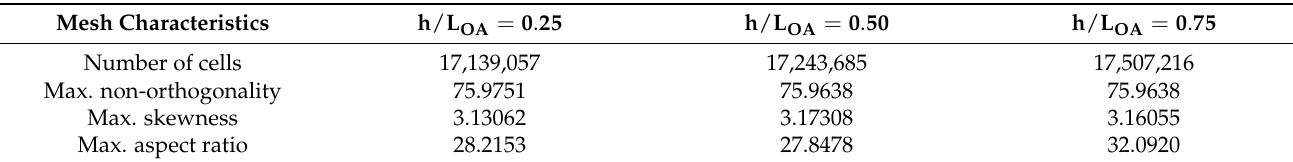
Table 5. Mesh characteristics for various depth